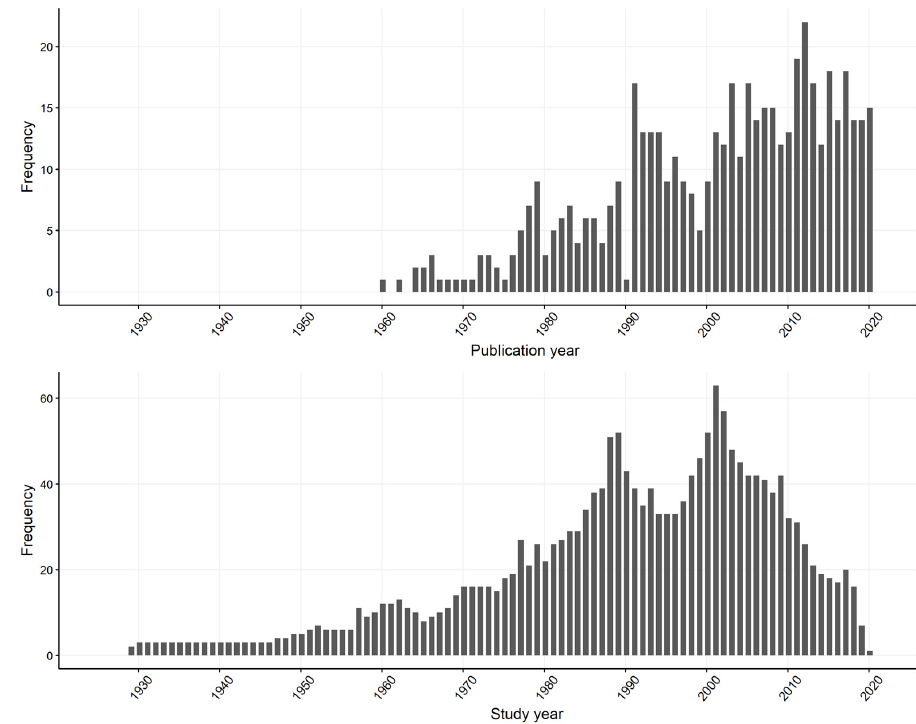
Figure 2. Distribution of the 514 studies captured from a scoping review of reported causes and syndromes associated with mid to late-term pregnancy loss in horses by ( top ) year of publication and ( bottom ) year of data collection from 1960–2020.